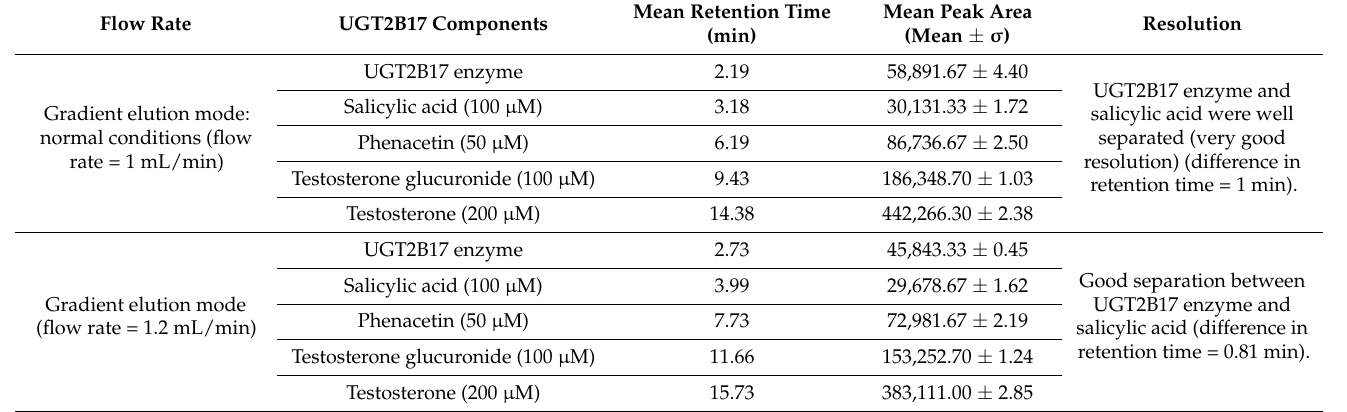
Table 3. Effect of flow rate on retention time and peak area of UGT2B17